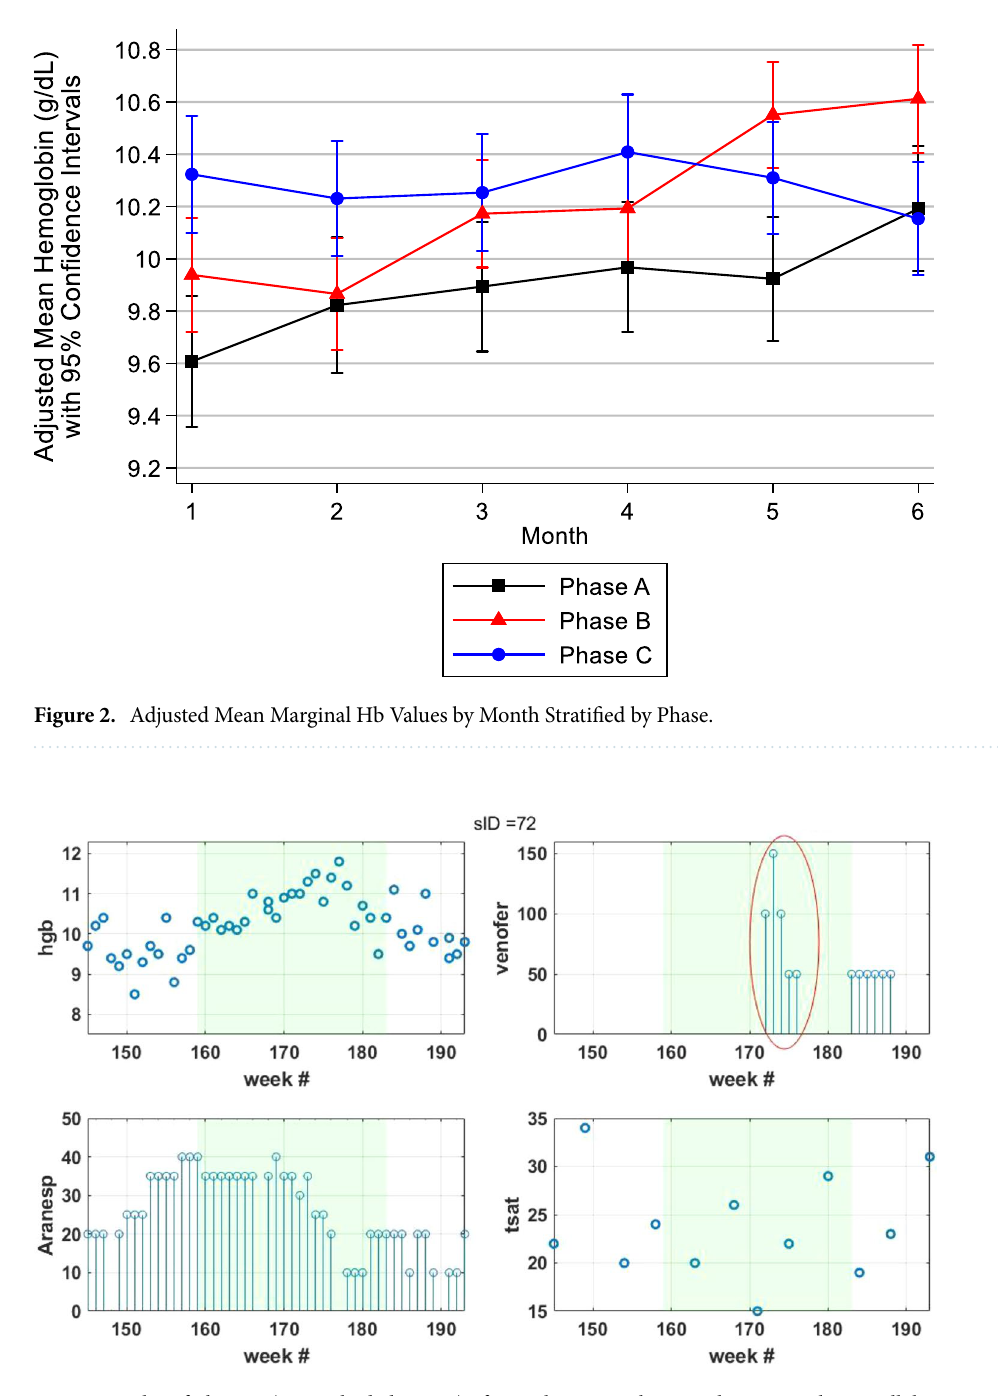
Figure 3. Plot of Phase C (green shaded region) of a single patient showing the temporal crosstalk between the effects of ESA and parenteral iron administration and the resulting Hb response. Displayed values are actual weekly or monthly lab results and ESA